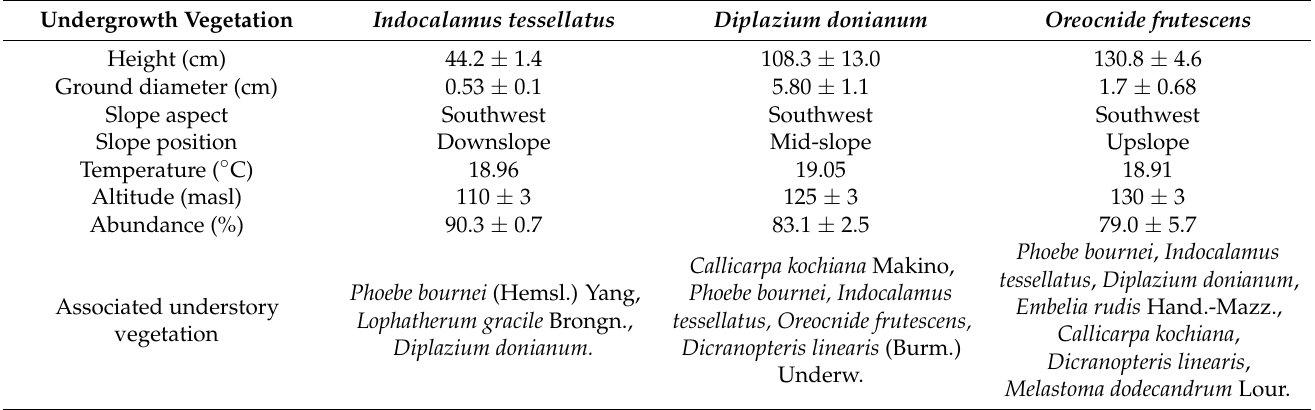
Table 1. Sample Site Information Sheet.